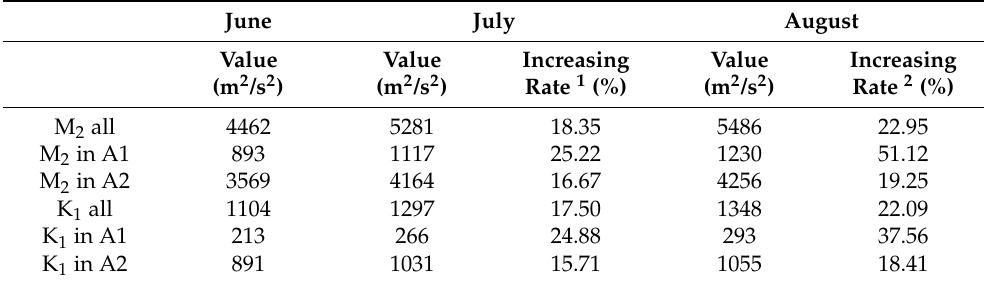
1,2 Increasing rates indicate July-on-June ratio, August-on-June ratio,